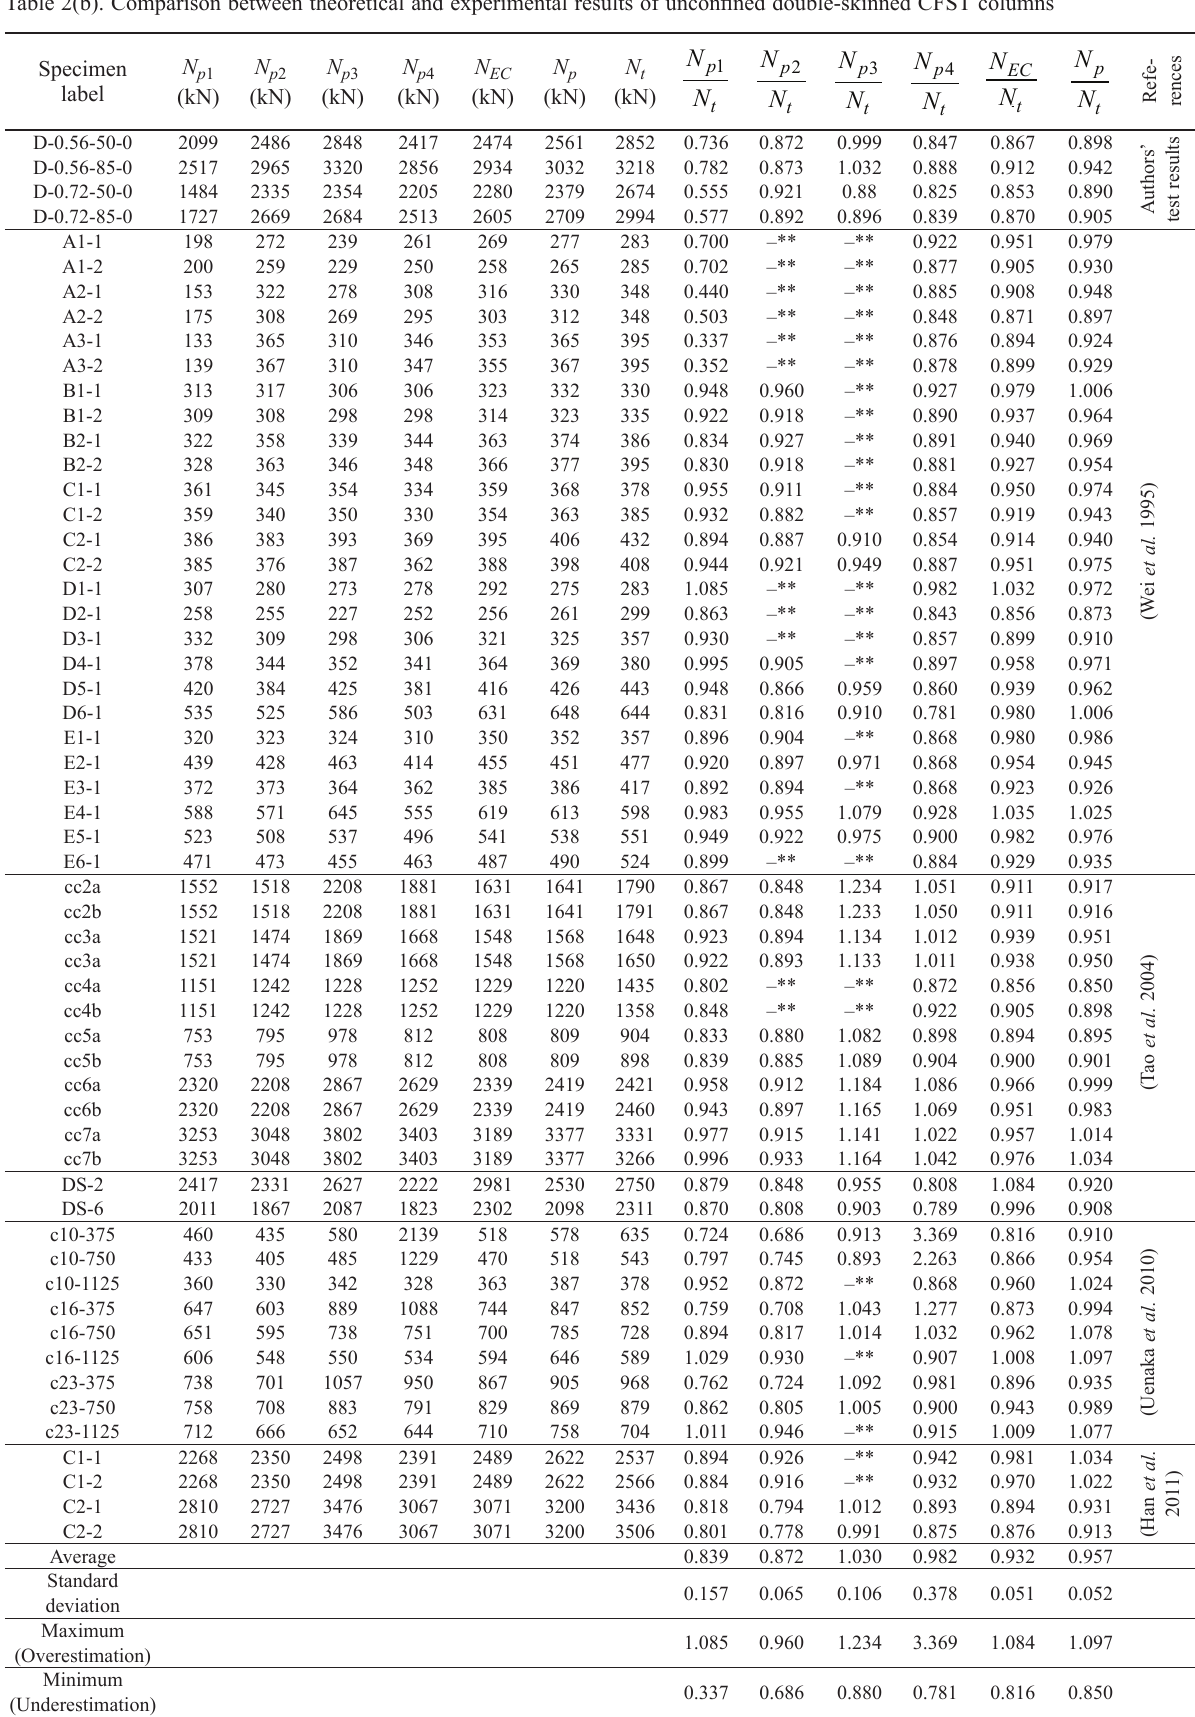
Table 2(b). Comparison between theoretical and experimental results of unconfined double-skinned CFST columns Specimen